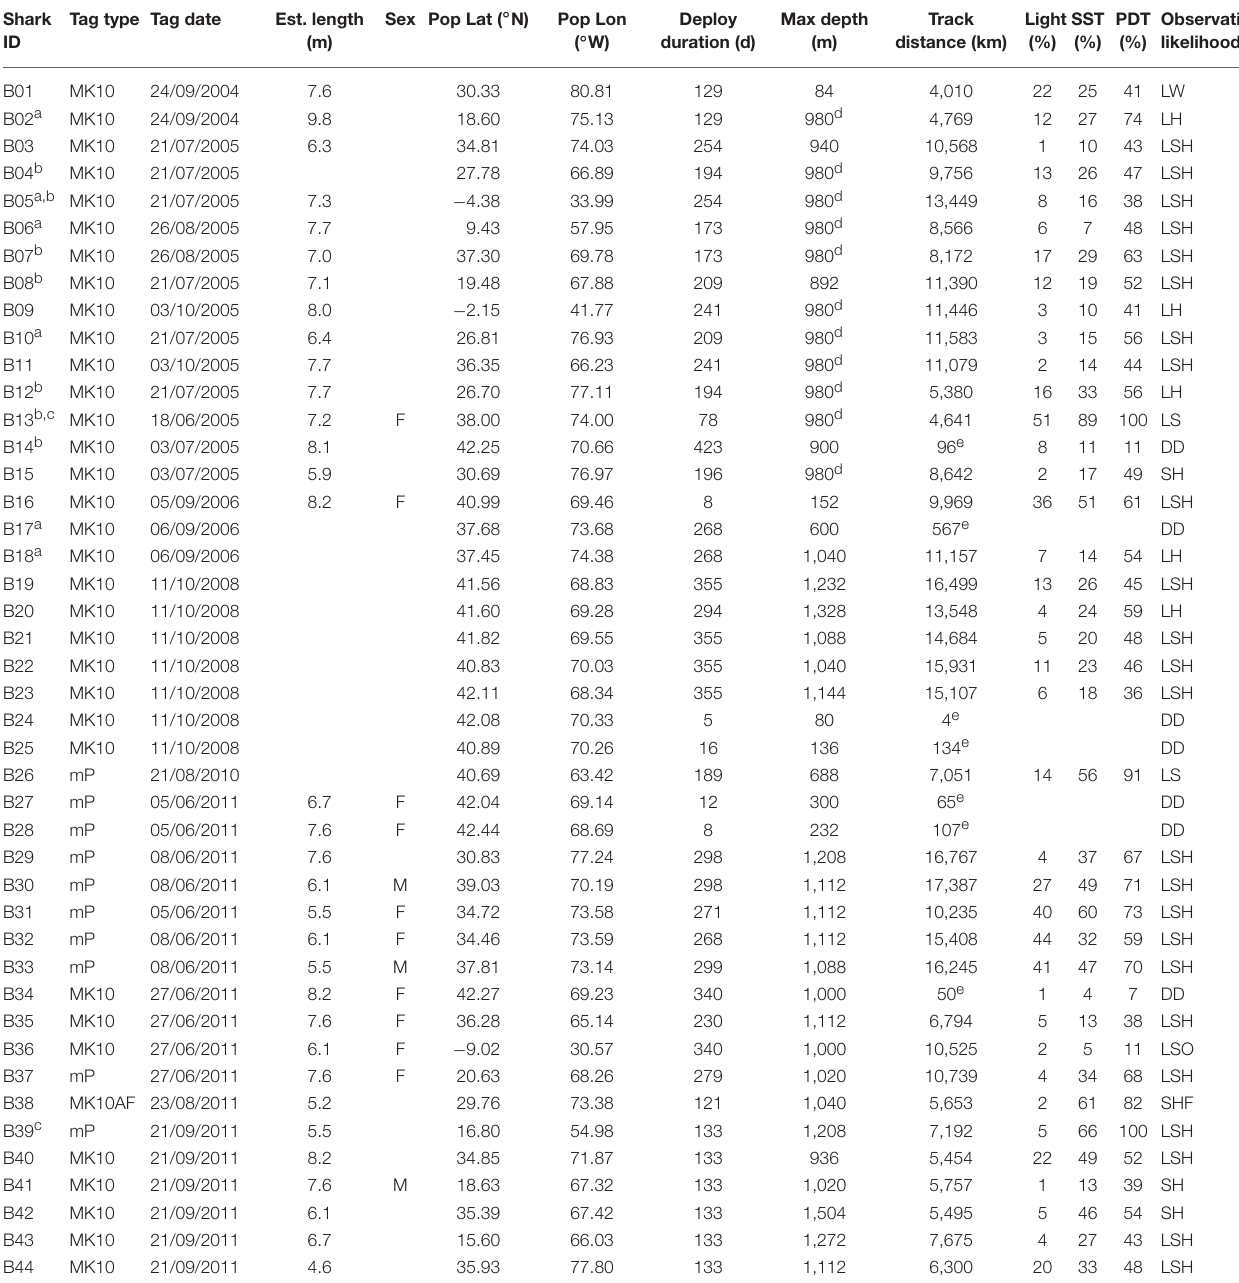
TABLE 1 | Summary information from satellite tag deployments on Cetorhinus maximus in the NW Atlantic. Shark